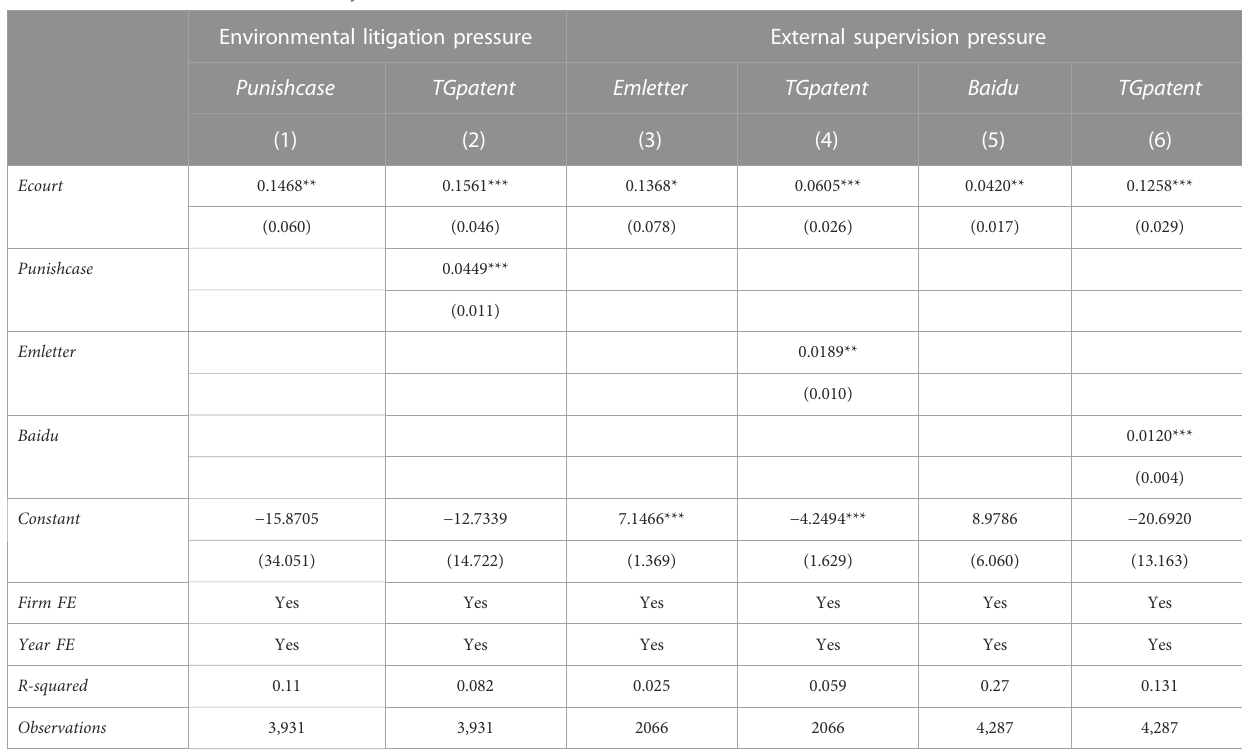
TABLE 6 The results of the mechanism analysis.